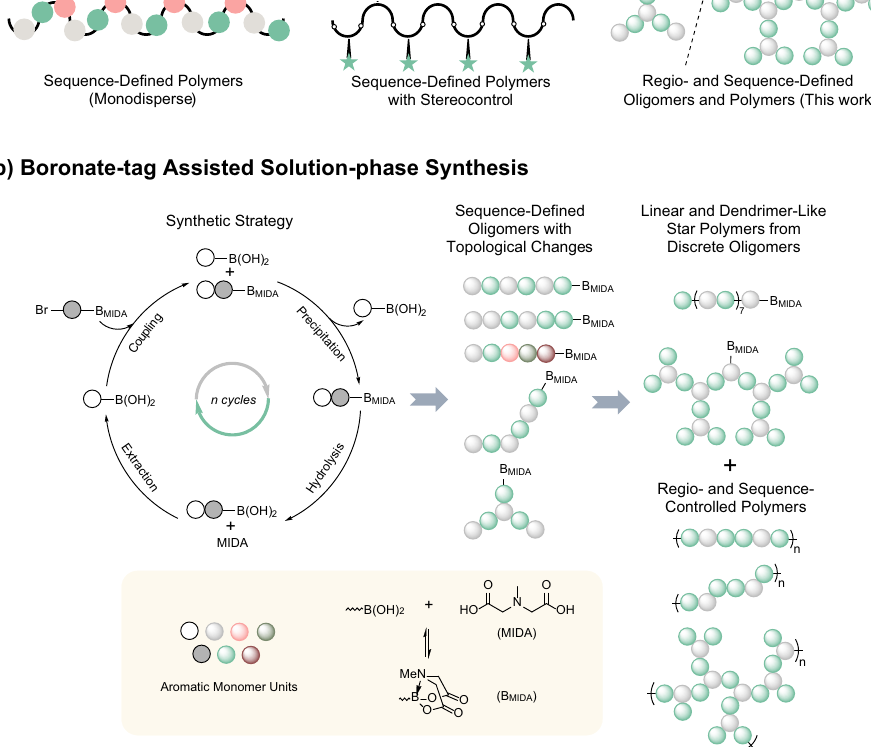
Fig. 1 Schematic illustration for sequence-de fi ned polymers and boronate-tag assisted solution-phase synthesis. a Schematic illustration for sequence- de fi ned polymers. b Regio- and sequence-controlled conjugated oligomers and polymers with topological variations synthesized using boronate-tag assisted solution-phase